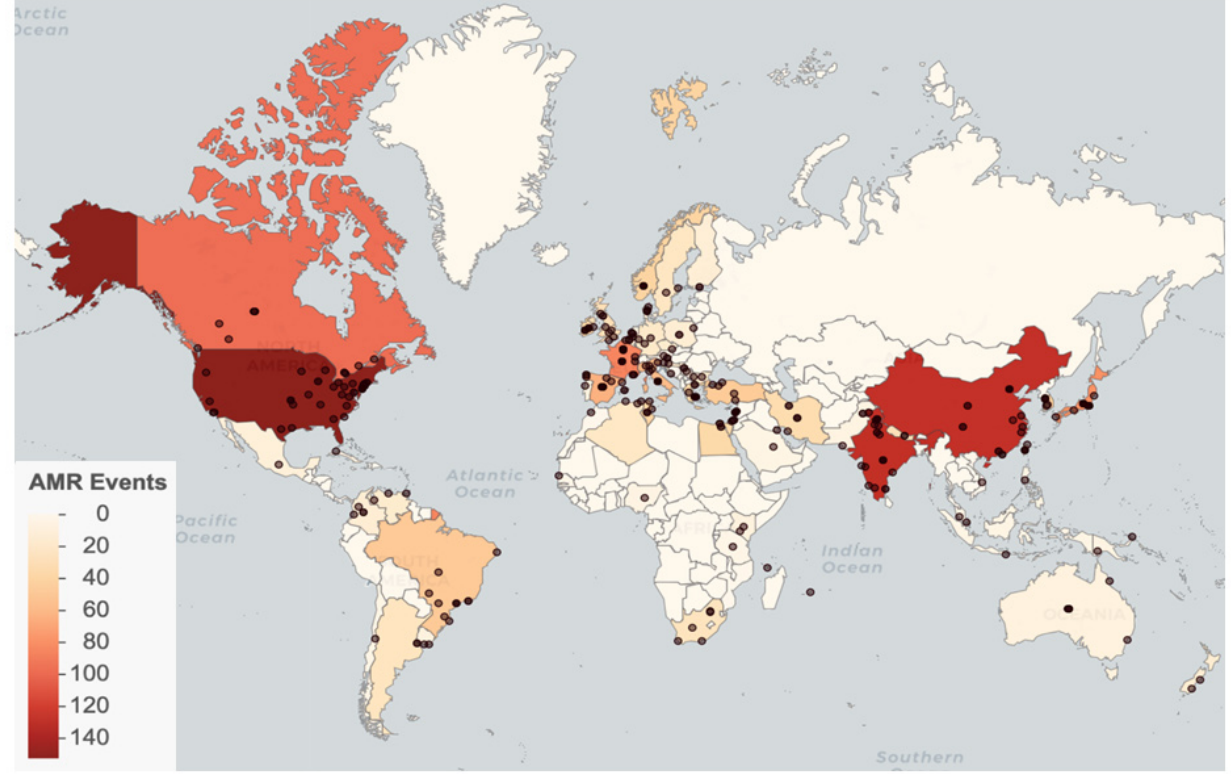
Figure 2. Global distribution of antimicrobial resistance (AMR) emergence events. Points represent locations. Countries are shaded by event count.